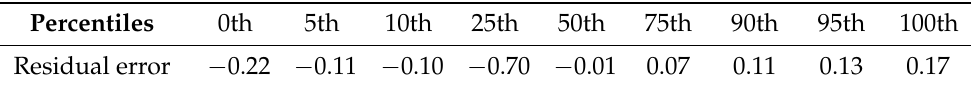
Table 3. Percentiles for residual